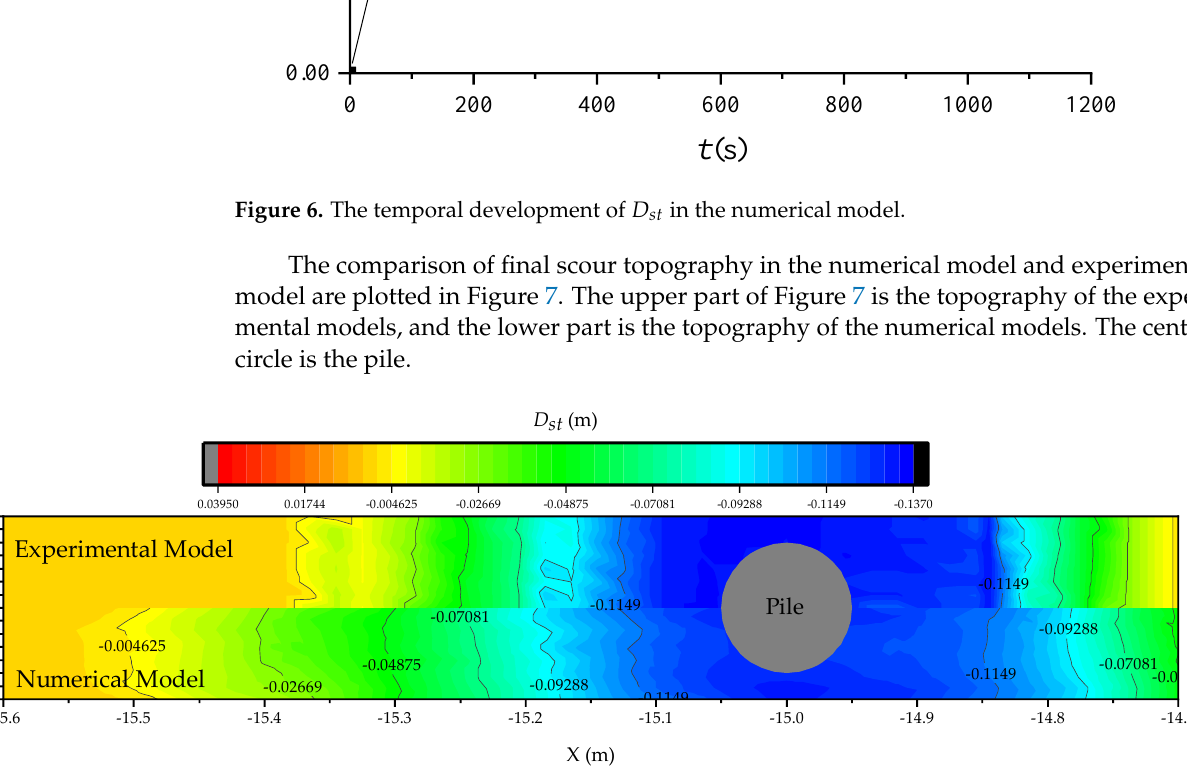
Figure 7. The comparison of the final topography in the numerical models and experimental model. Table 3. Numerical simulations of the present work.